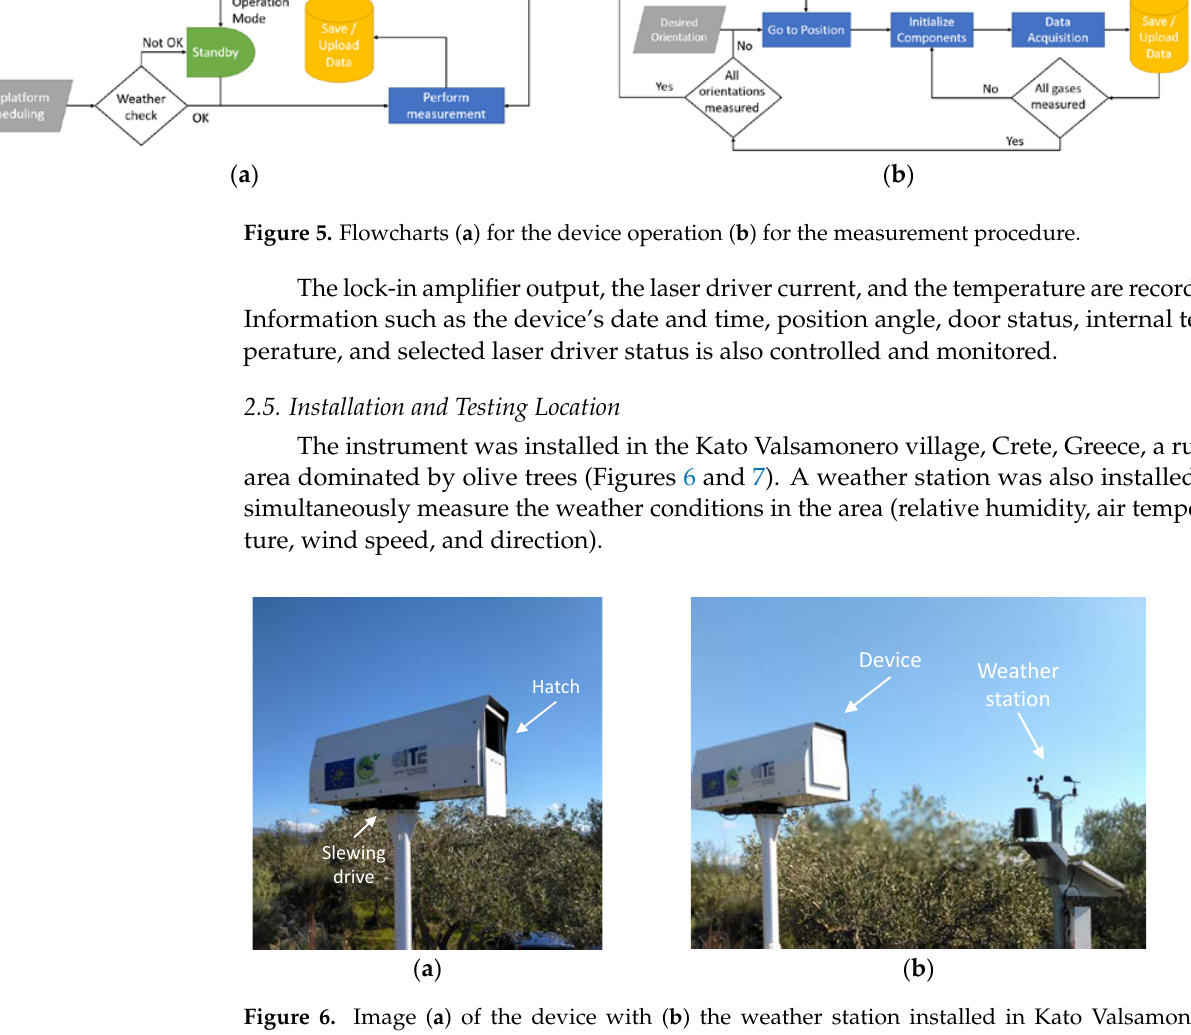
Figure 5. Flowcharts ( a ) for the device operation ( b ) for the measurement procedure.